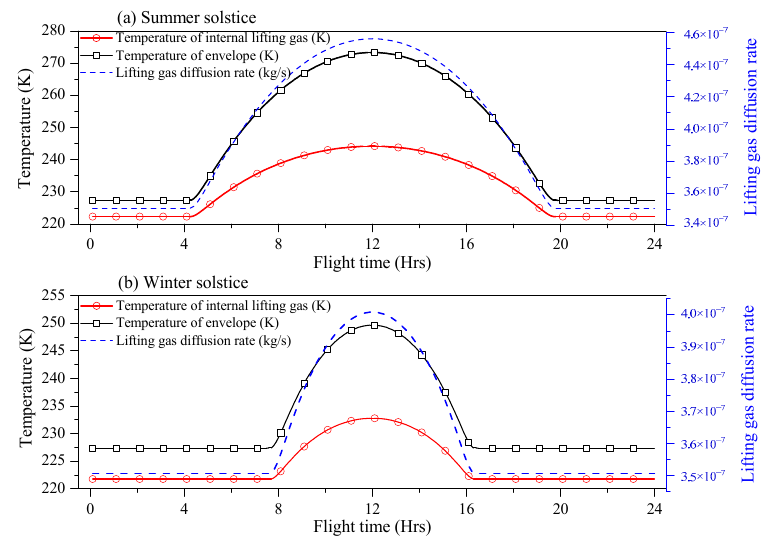
Figure 13. The temperatures of the lifting gas and envelope and the lifting gas diffusion rate at the ( a ) summer solstice and the ( b ) winter solstice.